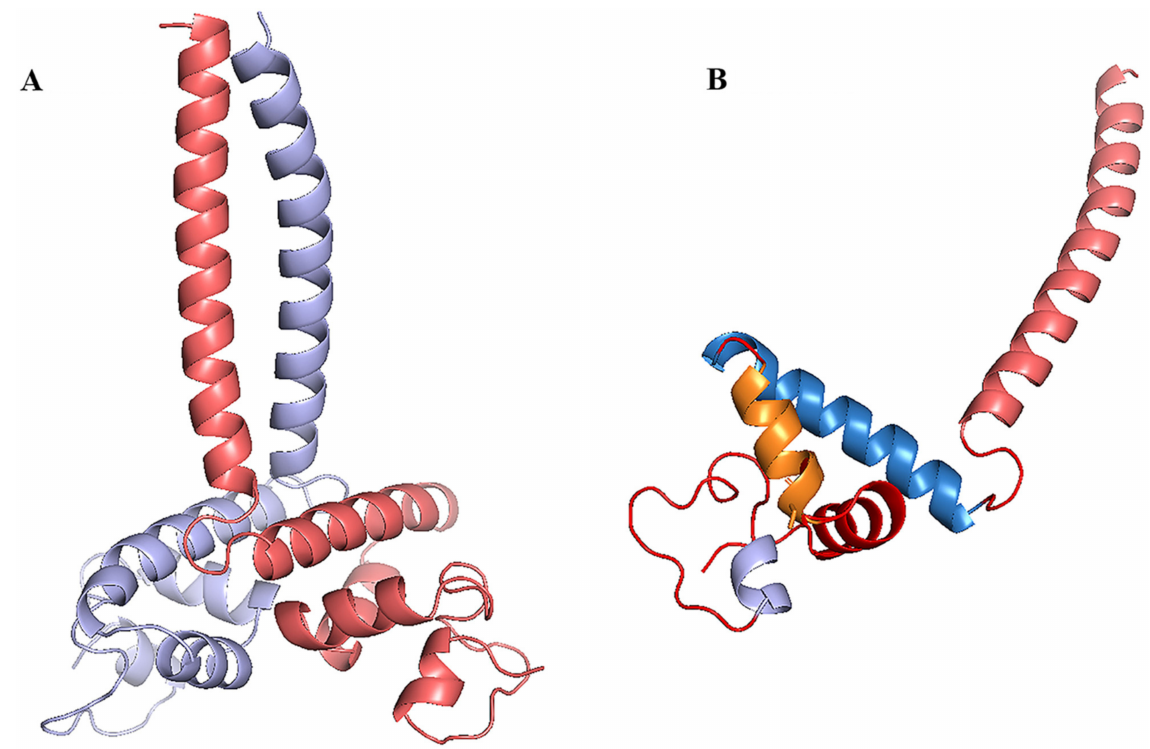
Figure 8. ( A ) The homology modeling of LBD15. ( B ) The structure of chain A in LBD15. The LBD15 protein contains a typical LOB domain displayed as dimers, which con- tained two centrosymmetric monomeric chains (chain A and chain B) (Figure 8A), and the monomeric chain consisted of five α -helixes (Figure 8B). The most reliable cis -elementin promoter of the m 6 A pathway genes that up-regulated more than 1.5-fold in the LBD15-oe plants were predicted, and the molecular docking of these cis -elements with LBD15 was performed. The results of cis -elements docking with LBD15 are shown in Table 2 and Figure S1. Among those 13 genes, PagFIP37b could be the most reliable to interact with LBD15 according to the Affinity. Table 2. Amino acid residues participate in protein–ligand docking between LBD15 and predicted cis -elements in the promoters of m 6 A pathway